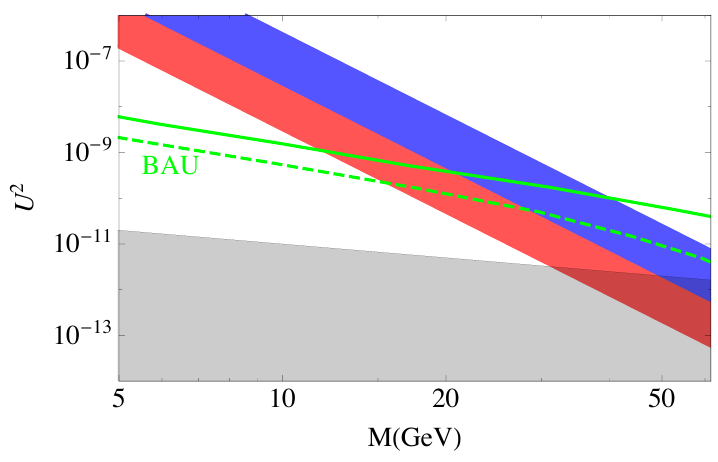
Figure 11 . Regions on the plane ( M; U 2 ) where LHC displaced track selection e(cid:14)ciency (eq. (3.20) and (3.21)) is above 10% in the IT (blue band) and MC (red band). The grey shaded region cannot explain the light neutrino masses and the green lines correspond to the upper limits of the 90%CL bayesian region for successful baryogenesis in the minimal model for NH (solid) and IH (dashed), taken from